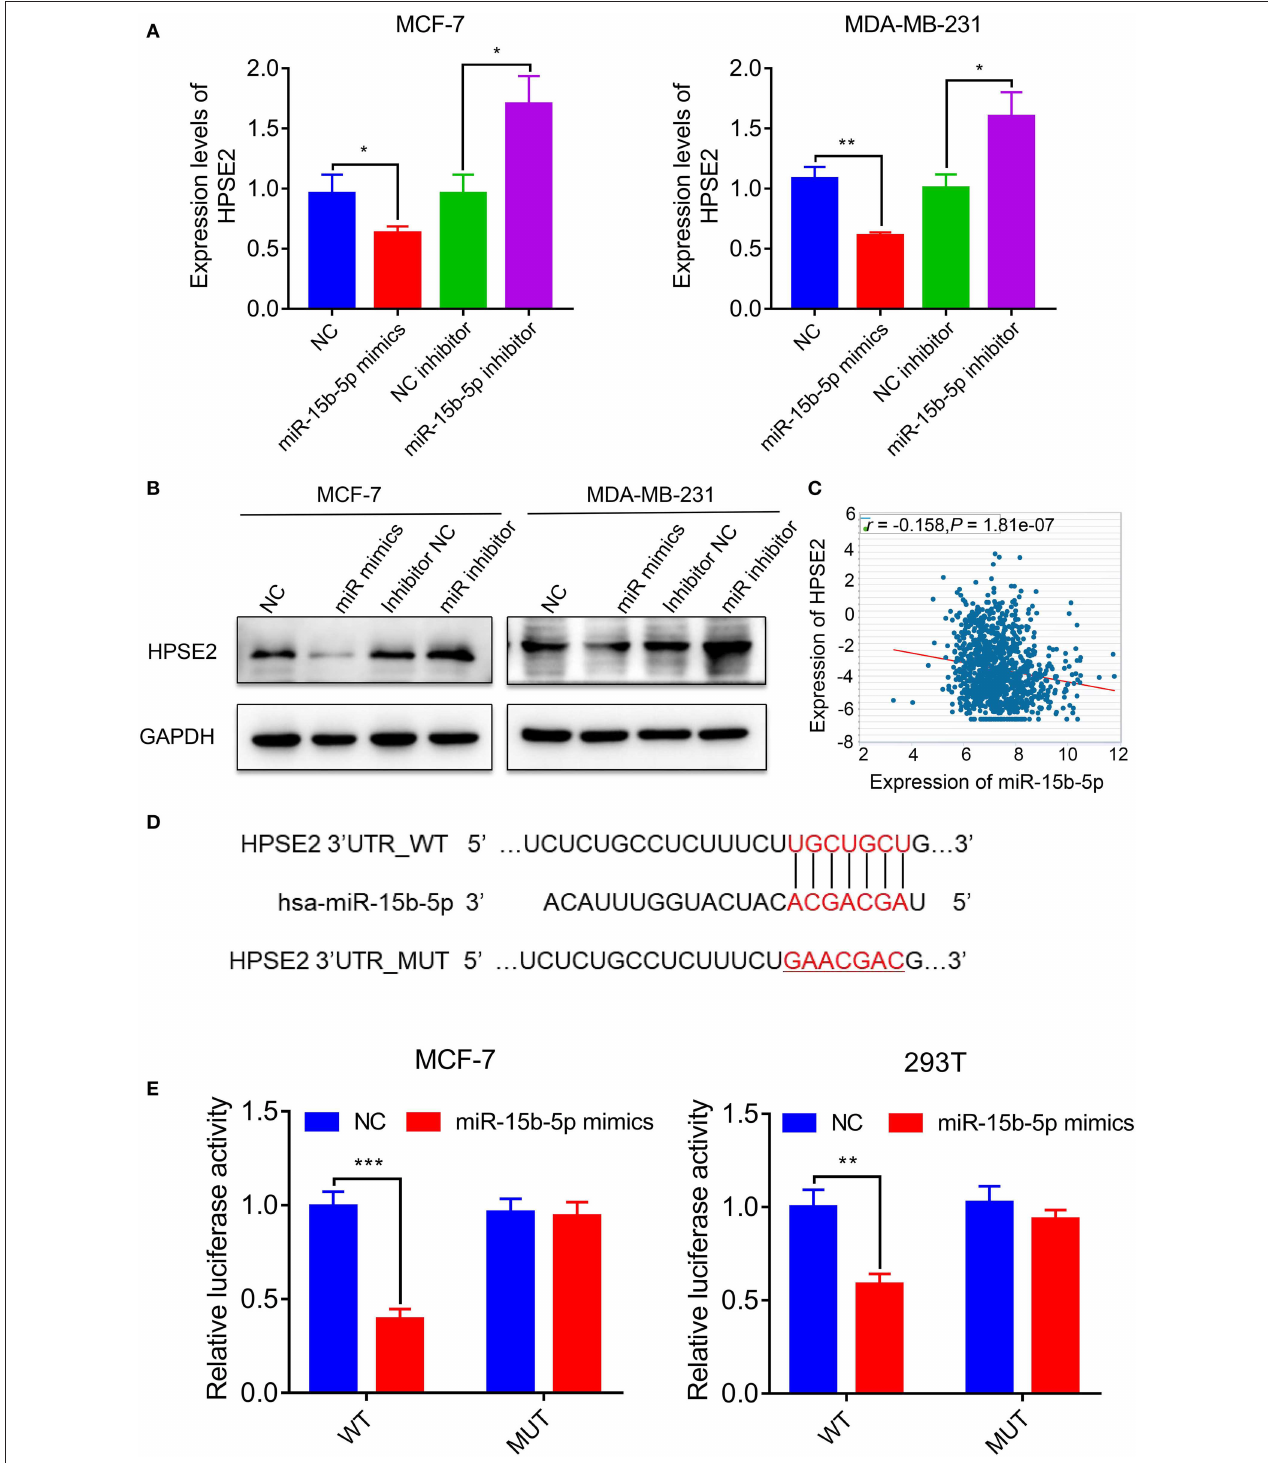
FIGURE 6 | HPSE2 is a target of miR-15b-5p. (A) The mRNA level of HPSE2 in breast cancer cells overexpressing or underexpressing miR-15b-5p. (B) The protein level of HPSE2 in breast cancer cells overexpressing or underexpressing miR-15b-5p. (C) miR-15b-5p expression is correlated with HPSE2 expression in BC from TCGA data. The r and P values are from Pearson correlation. (D) The predicted relationship between miR-15b-5p and HPSE2 via the bioinformatics prediction website. (E) The dual luciferase reporter assay demonstrated a targeted relationship between miR-15b-5p and HPSE2 in different cell lines (* P < 0.05, ** P < 0.01, and *** P <